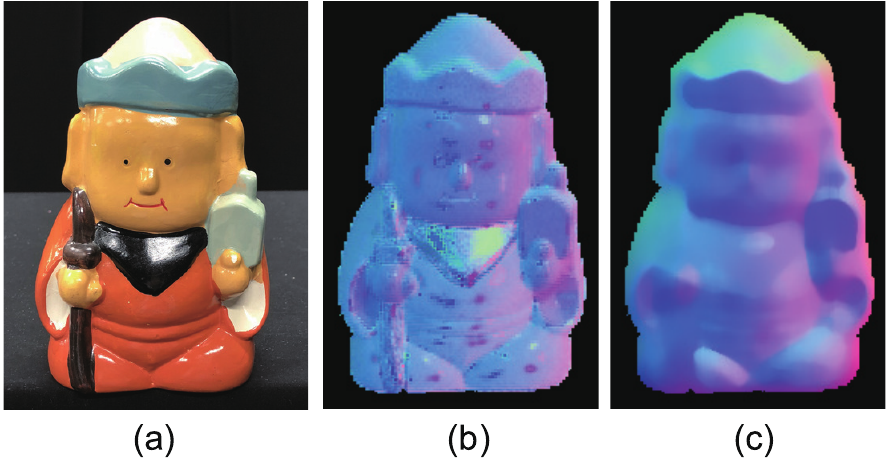
Figure 22. The results for buddha object, which causes strong specular reflection. Estimated surface normal [Buddha]: ( a ) Target object, ( b ) surface normal of naive color photometric stereo, and ( c ) surface normal of our method. The proposed method can smooth the surface normal of the scarf whose surface normal is unreliable due to black